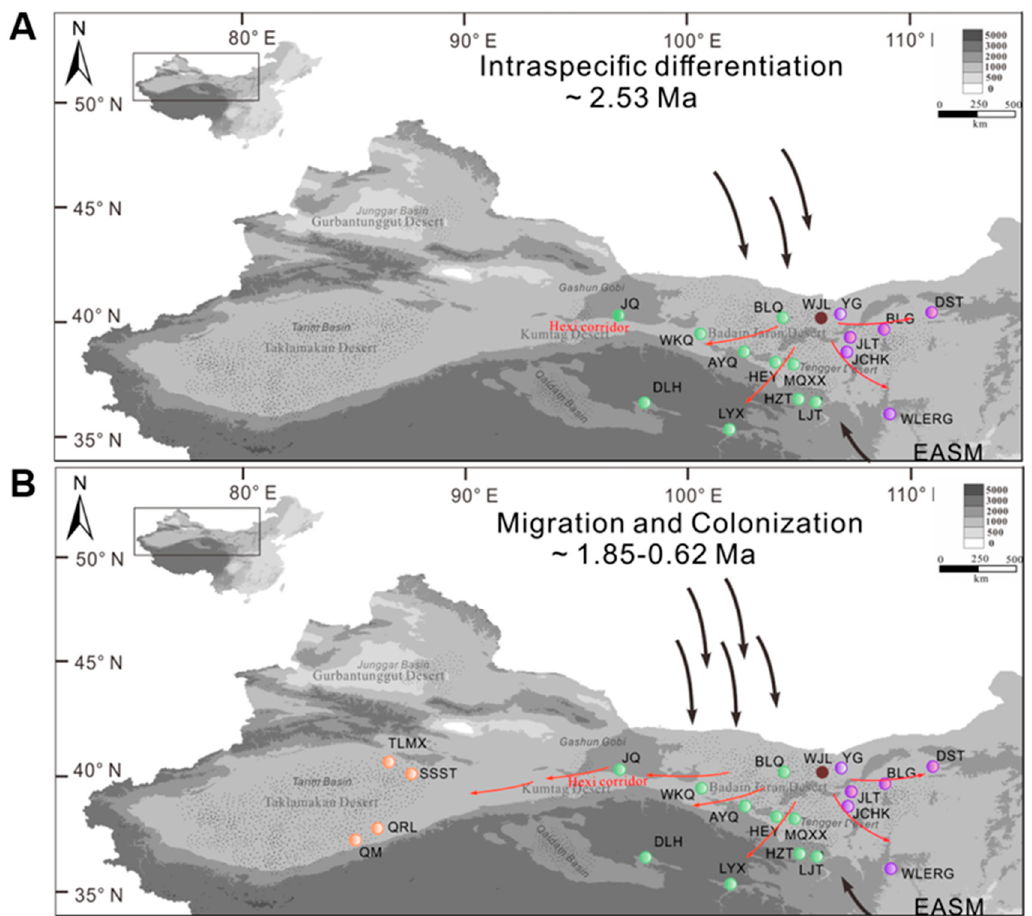
Figure 7. Proposed historical patterns of the migration and recolonization of Nitraria tangutorum in arid northwest China. ( A ) ~2.53 Ma: intraspecific differentiation occurred within the eastern groups of N. tangutorum triggered by the initial strengthening of the East Asian winter monsoon (EAWM). ( B ) ~1.82–0.62 Ma: putative routes of migration and recolonization of N. tangutorum across the Hexi corridor supported by the climatic conditions established by the EAWM. Color coding is consistent with Figure 2: brown spots represent the ancestor of N. tangutorum ; purple, green and orange spots represent the haplotypes from the East-A, East-B, and West lineages, respectively. Red arrows represent the putative dispersal routes of N. tangutorum . Black arrows and number of arrows represent the direction and intensity of the EAWM and East Asian summer monsoon (EASM), respectively.